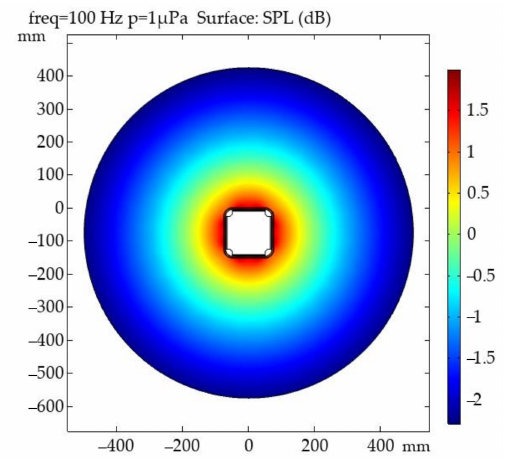
Figure 5. Sound pressure level (dB re 1 µ Pa) in model’s acoustic domain.